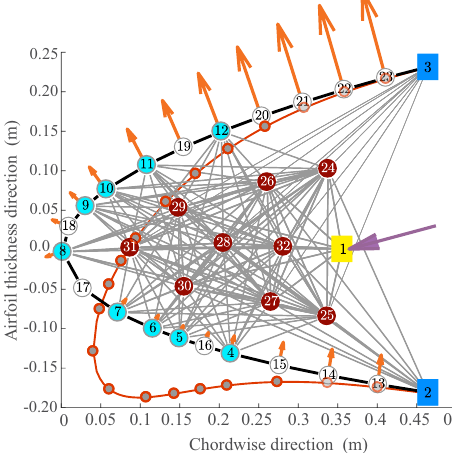
Figure 12. Initial population and load path model set-up: load path network (grey), active output points (cyan), deactivated output points (white) to improve the distribution of the external loads (orange arrows), internal structure points (red), constraint points (blue), input actuation point (yellow), and stroke actuation (purple arrow). Target points are placed along the target (red) curve, at the same arclength as the output points.